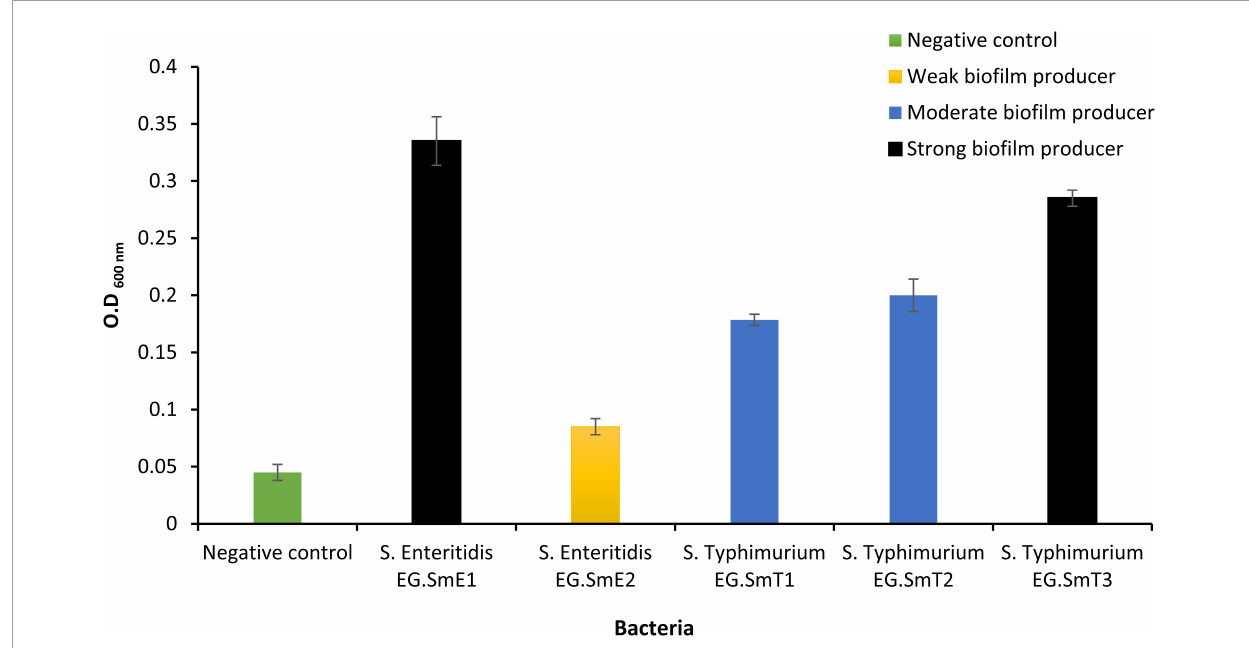
FIGURE1 Quantitative evaluation of biofilm formation by five Salmonella serovars. Bacteria in the current study were classified into three categories; weak biofilm producers ( S . Enteritidis EG.SmE2), moderate biofilm producers ( S . Typhimurium EG.SmT1 and S . Typhimurium EG.SmT2), strong biofilm producer ( S . Enteritidis EG.SmE1 and S . Typhimurium EG.SmT3). The negative control represents the optical density cutoff value. Data shown represent the average of three reads ± standard